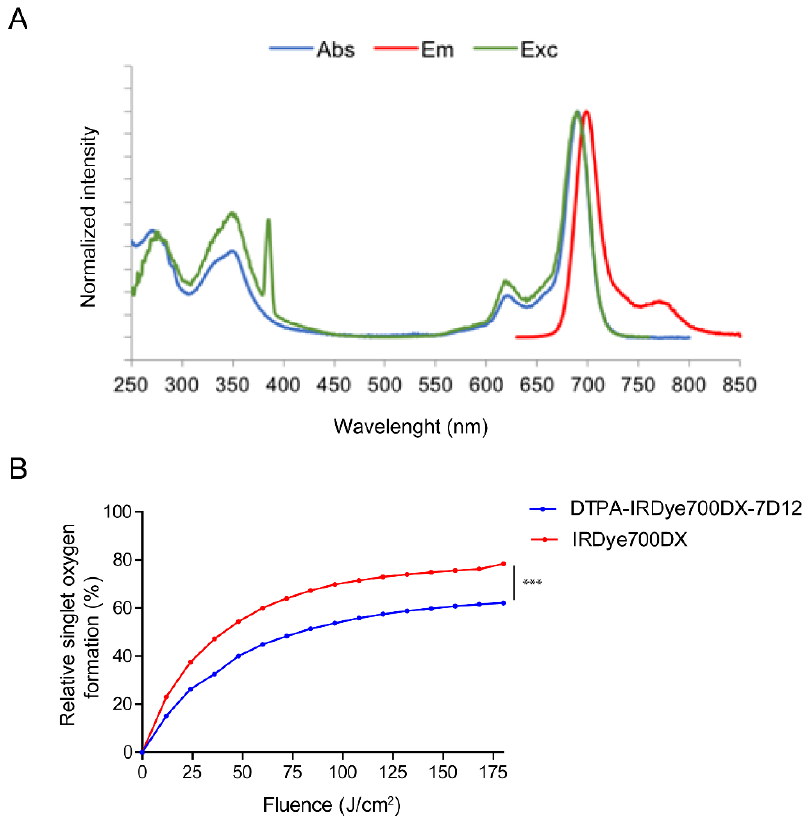
Figure 2. ( A ) Normalized photophysical spectra (absorbance, excitation and emission) of bimodal conjugate DTPA-IRDye700DX-7D12. ( B ) Formation of singlet oxygen upon illumination with 200 mW/cm 2 690 nm light by IRDye700DX and conjugate DTPA-IRDye700DX-7D12. *** p < 0.001, as determined with two-way ANOVA for repeated measures with Bonferroni post-hoc test.